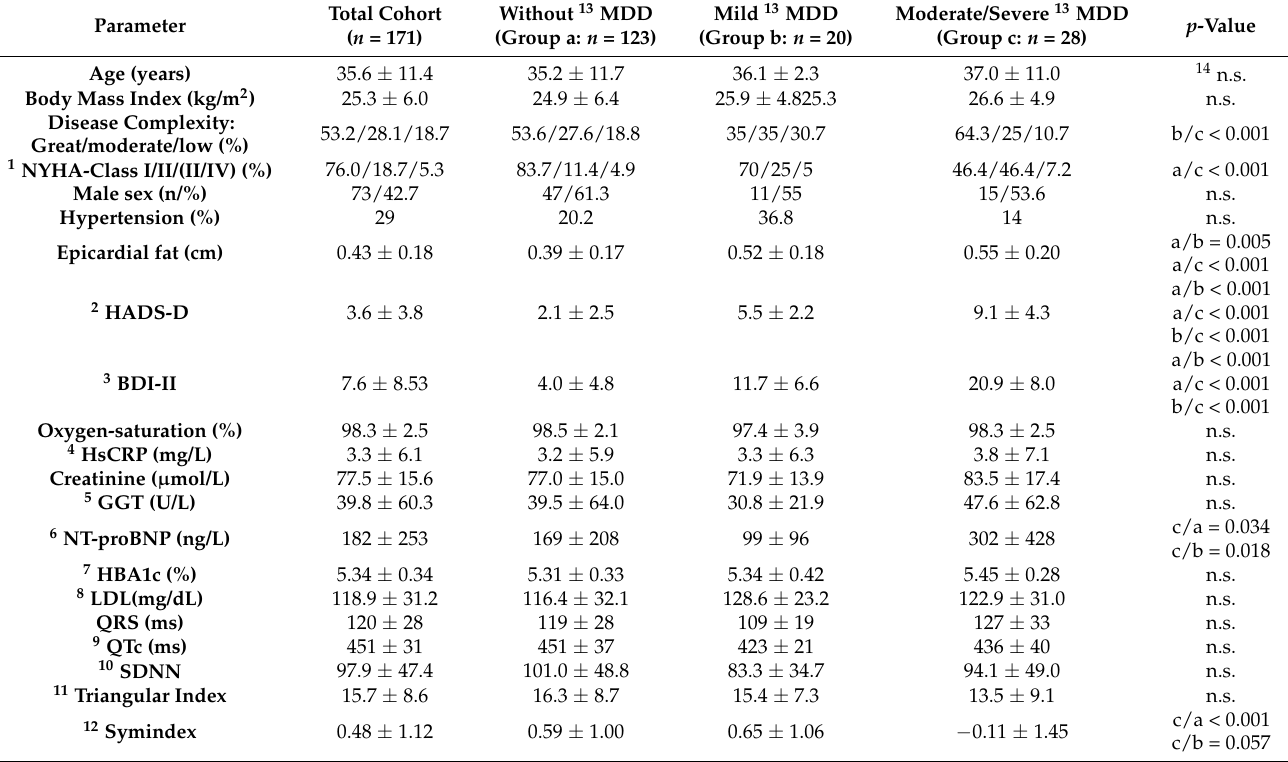
Table 2. Patients’ characteristics. Baseline characteristics of the total cohort and patients stratified according depressive state. Mild depression did not exhibit significantly reduced heart rate